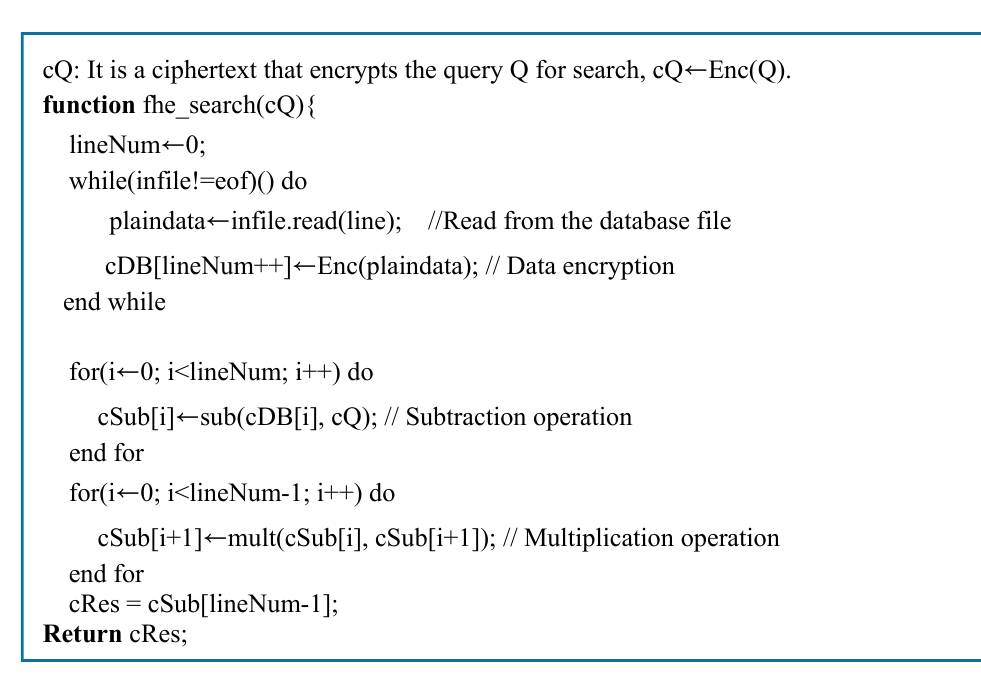
11 of 19 Figure 6. Search protocol.